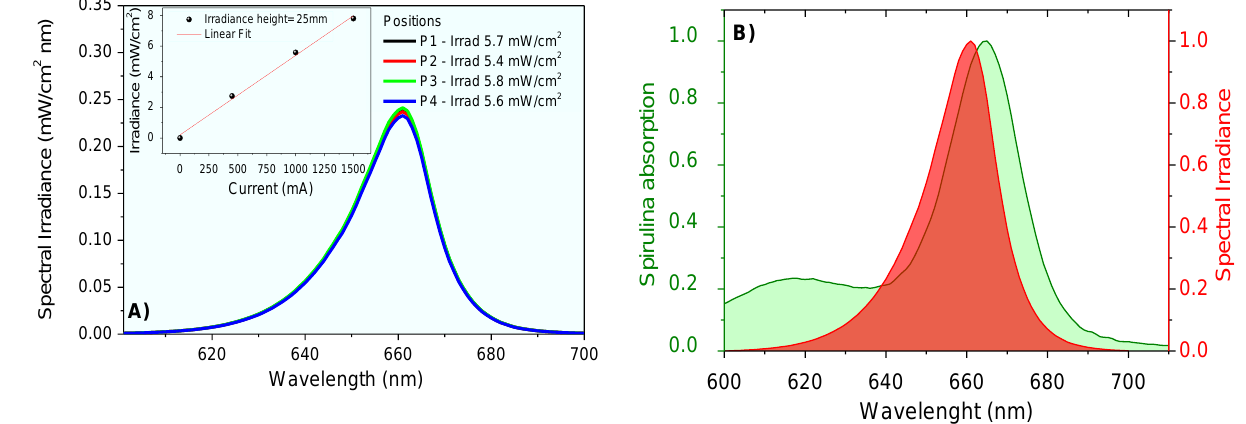
Figure 4. Spectral irradiance at 2.5 cm using different currents ( A ), and irradiance data linear correlations (insert); ( B ) spectral overlap between chlorophyll absorption and light source emission (normalized spectra).